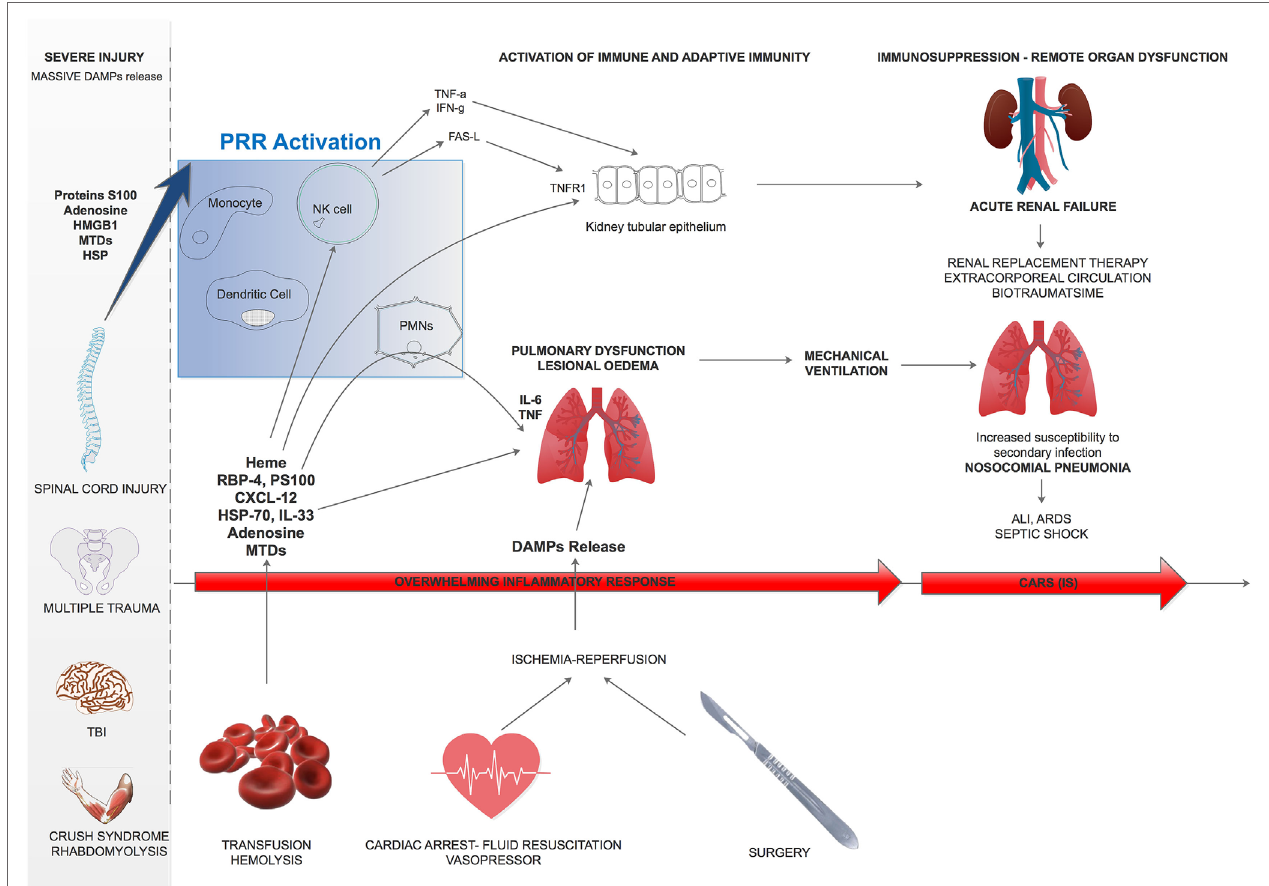
FiGURe 3 | Damage-associated molecular patterns (DAMPs) effect overview on remote organ dysfunction after trauma. After severe trauma, multiple DAMPs are released and can trigger lung edema or kidney tubular epithelium activation. Besides, subsequent transfusion, fluid resuscitation and surgery will worsen these phenomenon and lead to remote acute organ failure. ALI, acute lung injury; ARDS, acute respiratory distress syndrome; CARS, compensatory anti-inflammatory response; PMN, polymorphonuclear leukocytes; MTD, mitochondrial damage-associated molecular patterns; RBP4, retinol-binding protein-4; PS100, protein S100; HSP, heat-shock protein; TNFR1, Type 1-TNF receptor; TNF- α , tumor necrosis factor- α ; HMGB1, high-mobility group box